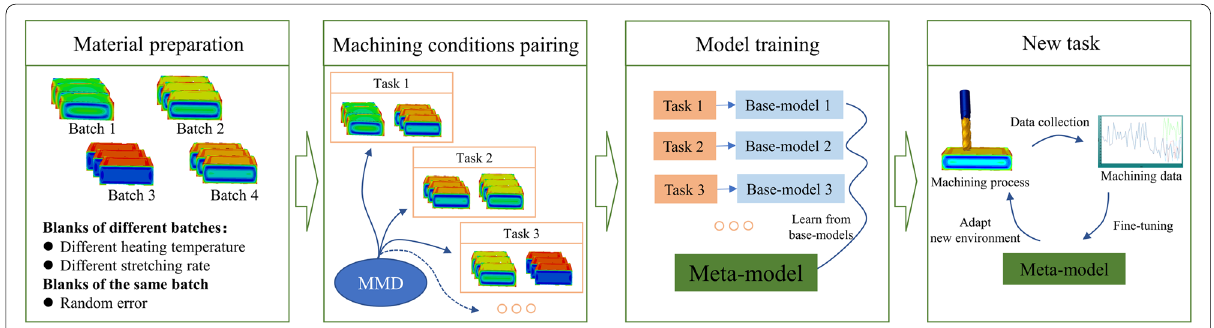
Fig. 2 Flowchart of proposed